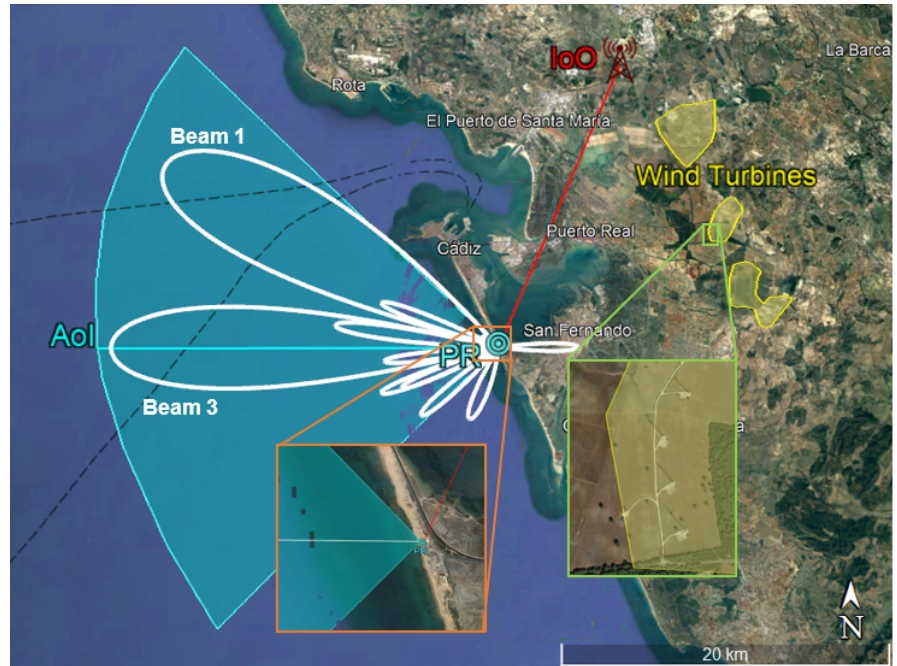
Figure 5. Sketch of the trials scenario located in Cádiz. It shows the IoO and PR locations, the Area of Interest and wind turbines interference areas. The pattern of the two beams under study are also superimposed: beam 1 steered to − 30.5 ◦ and beam 3 steered to 0 ◦ .